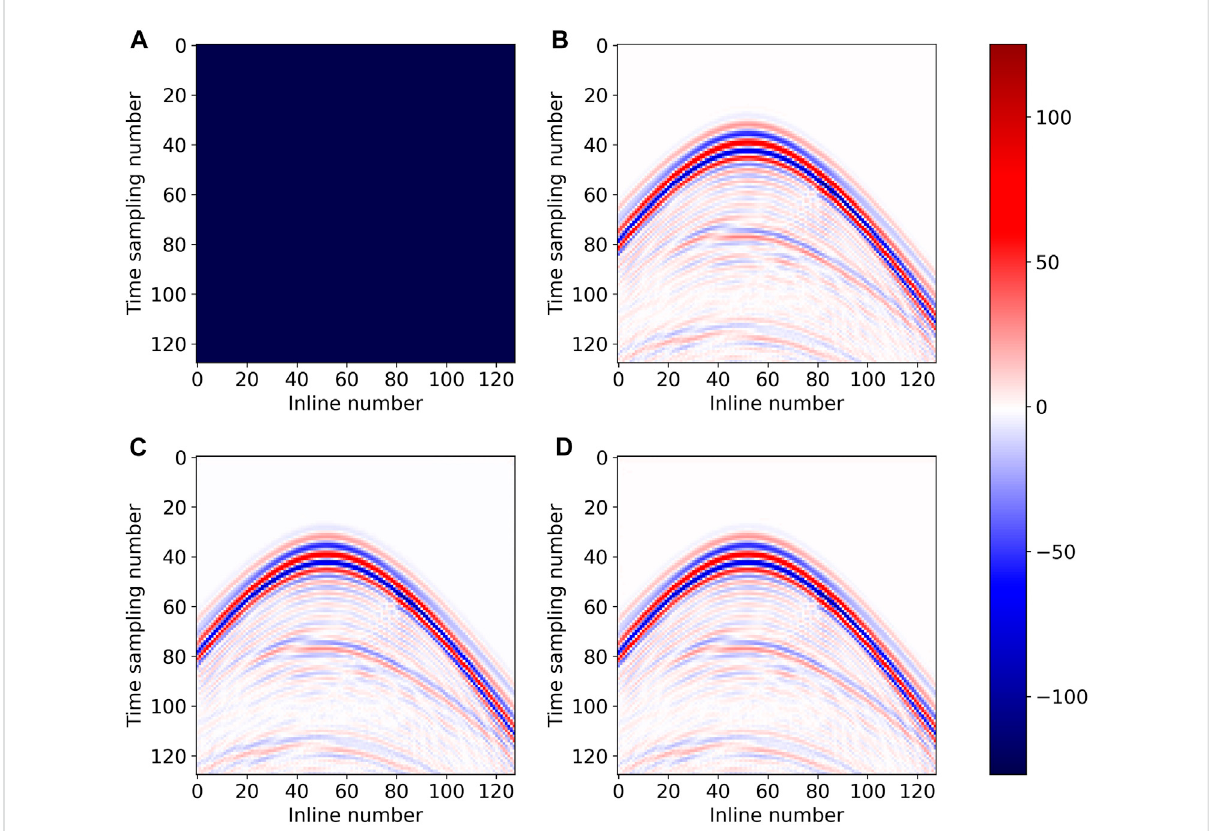
FIGURE 8 CrosslinesliceofinterpolationresultsontheSEGC3syntheticdata: (A) (completecrossline)missingtracesdata; (B) groundtruth; (C) Unet(Chai et al., 2021); and (D)